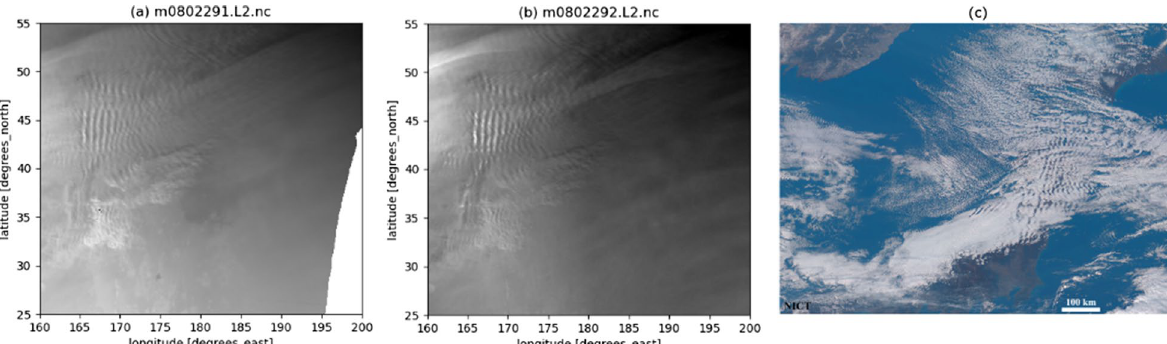
Fig. 1 An example of cloud trains on Mars and Earth. a and b are red and blue band images, respectively, observed in the eastern side of the Phlegra Montes by MGS/MOC on Oct. 10, 1999 (Mars Year 24 and solar longitude, L s , panel visualizes a lee wave. c is another example of terrestrial mountain lee waves observed by Himawari 8 on Nov. 17, 2016. The white bar in c corresponds to 100